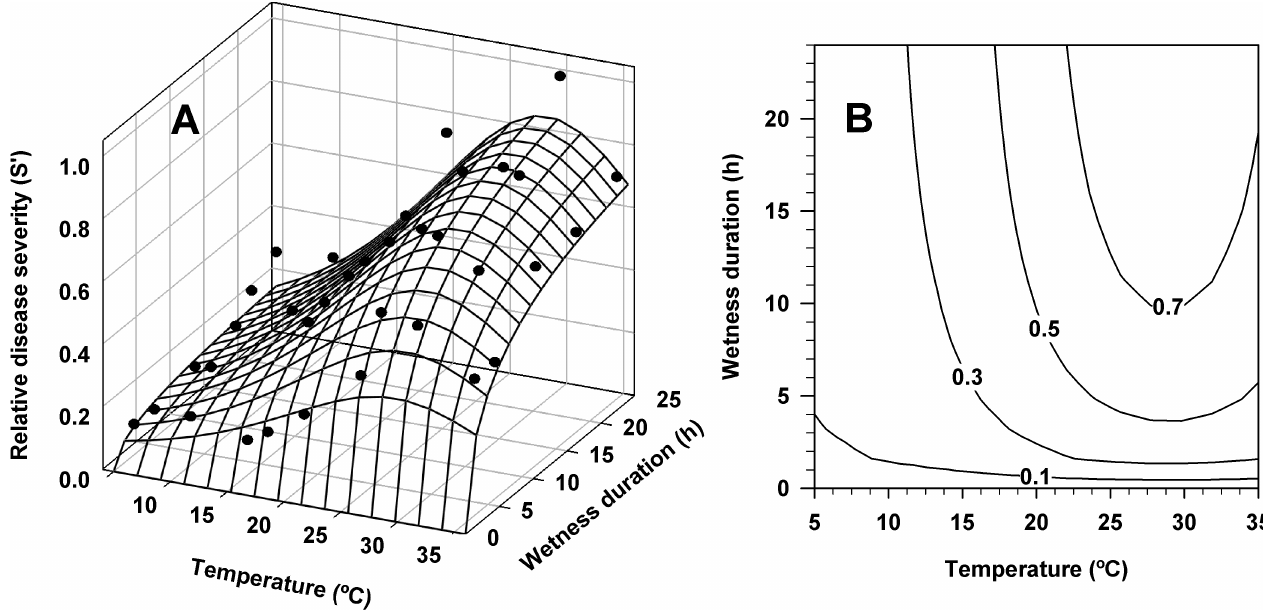
Fig 2. Three-dimensional response (A) and contour plot (B) of the combined effects of temperature and leaf wetness duration on relative disease severity caused by Xanthomonas arboricola pv. pruni on peach-almond hybrid GF-677 plants. The predicted values were calculated using the reduced form of Duthie’s model, corresponding to Eq 5. (A) The black points correspond to mean relative disease severity of two independent experiments and five plants per experiment observed 21 days after bacterial inoculation. (B) An area represents relative disease severity values lower than or equal to the label on the contour line on the right of the area.